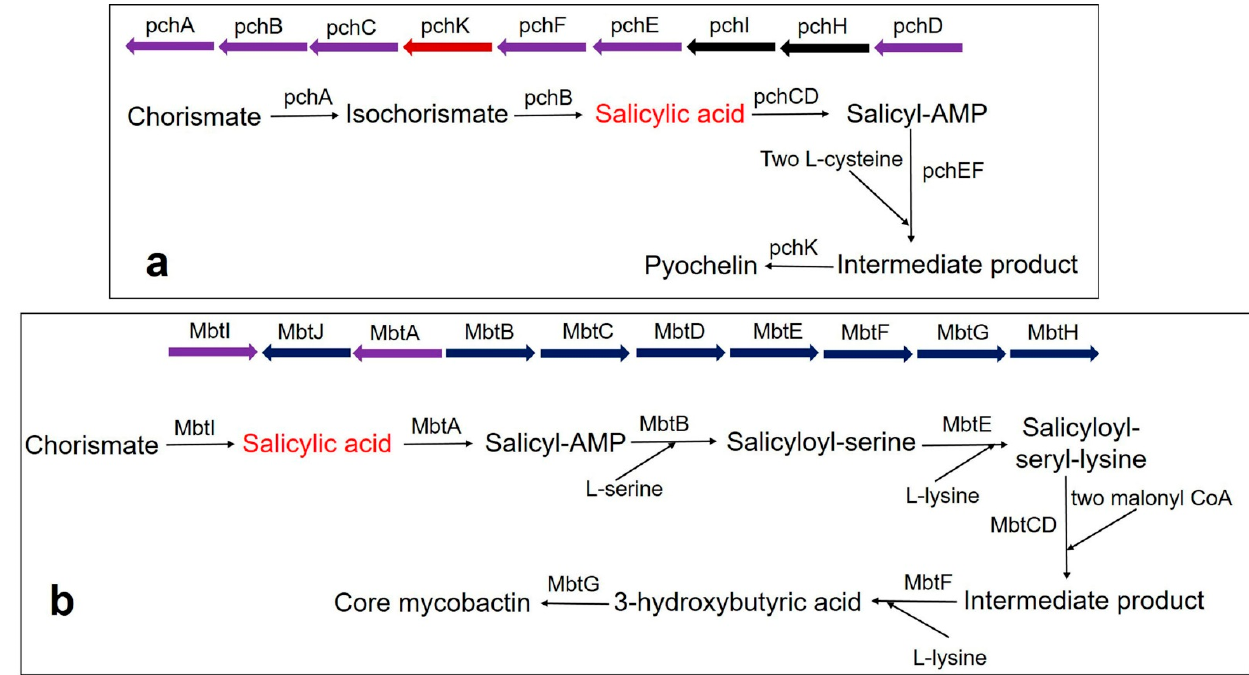
Figure 3. Biosynthesis pathway of catecholate siderophore in bacteria ( a ) Pyochelin biosynthesis in P. aeruginosa using BGC comprising the pchDHIEFKCBA operon. The biosynthesis of pyochelin is initiated from chorismate by two salicylic acid synthesizing enzymes pchA (ICS) and pchB (IPL), encoded by NRPS BGC. Other gene encoding enzymes are pchC (type II thioesterase); pchD (salicyl-adenylating enzyme); pchE and pchF (tailoring enzyme that adds L-cysteine and performs cyclization and epimerization); pchK (saccharopine reductase); pchH and pchI (transporter enzyme). ( b ) Core mycobactin scaffold biosynthesis in M. tuberculosis by using BGC comprising the MbtA-J operon. Biosynthesis is carried out by a cluster consisting of 10 essential gene encodings for the enzyme (MbtA-MbtJ). Conversion of chorismate to salicylate requires the main enzyme, MbtI. MbtI (salicylate synthase); MbtA (salicyl-adenylating enzyme); MbtB (enzyme for acyl carrier protein); MbtB and MbtE (enzyme for the addition of serine and lysine residues, respectively); MbtC & MbtD (enzyme for the addition of malonyl CoA residues); MbtF (enzyme for the addition of terminal lysine); MbtG (enzyme for N6-hydroxylation of L-lys); MbtJ and MbtH (enzyme encoding unknown